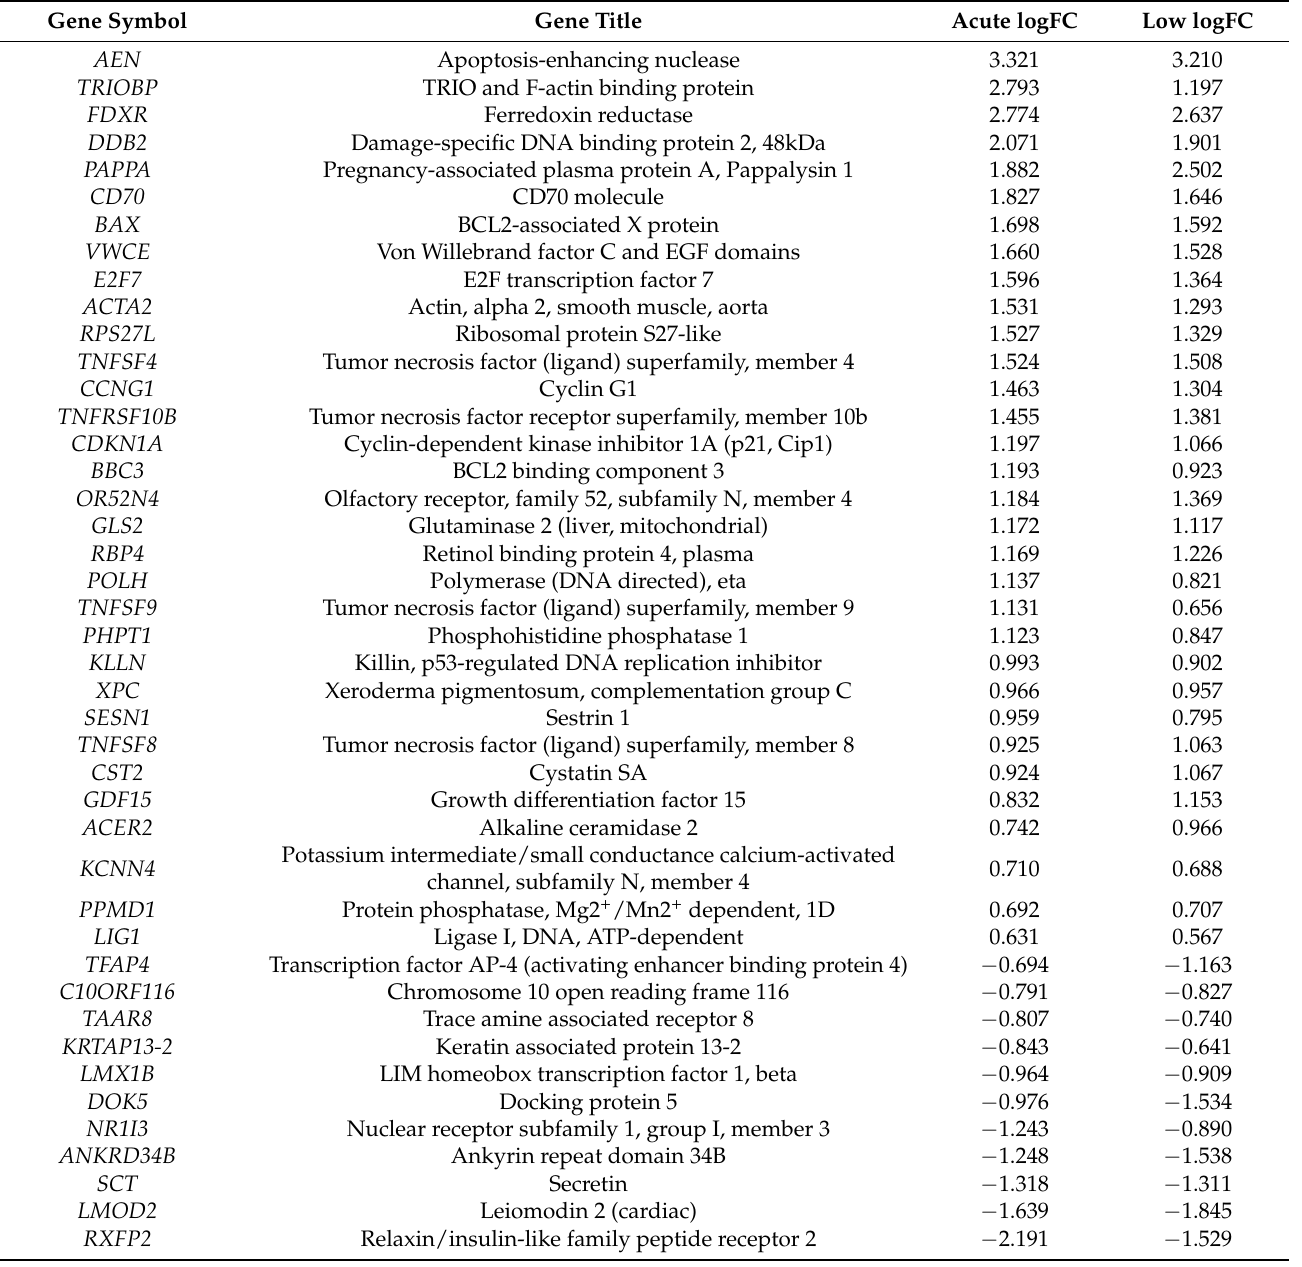
Table A1. List of genes for the dose of 0.56 Gy that are common in both lists of the two administration regimes for this dose, acute or low dose.